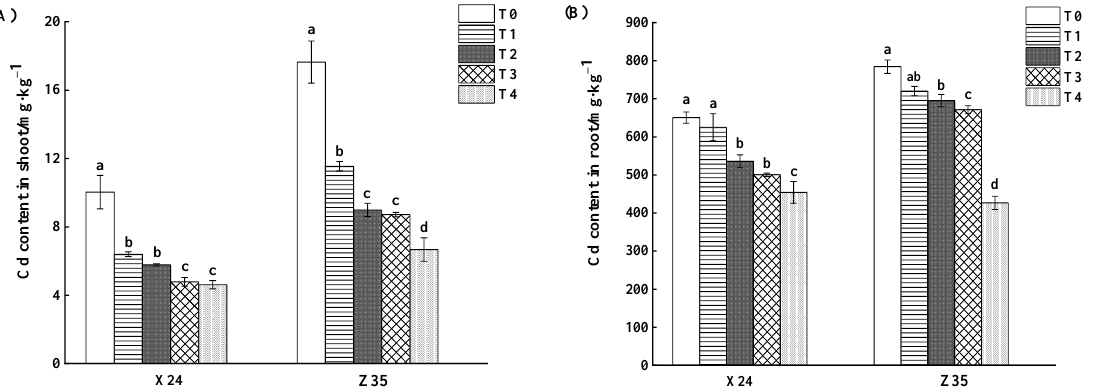
Figure 2. Effects of chlorinated amino acetic acid on cadmium content in shoots ( A ) and roots ( B ) of rice seedlings. T0, T1, T2, T3 and T4 respectively represent the application of 0, 0.2, 0.5, 0.8 and 1.2 mmol·L −1 chlorinated amino acetic acid treatment. Different lowercase letters indicate significant differences between treatments ( p < 0.05).